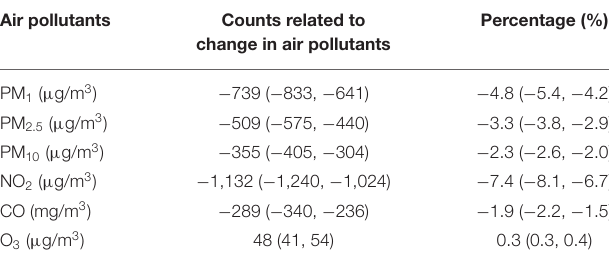
TABLE 3 | Estimated counts of ischemic stroke cases related to the change in air pollutants in the lockdown phase relative to the counterfactual lockdown phase of the past 2